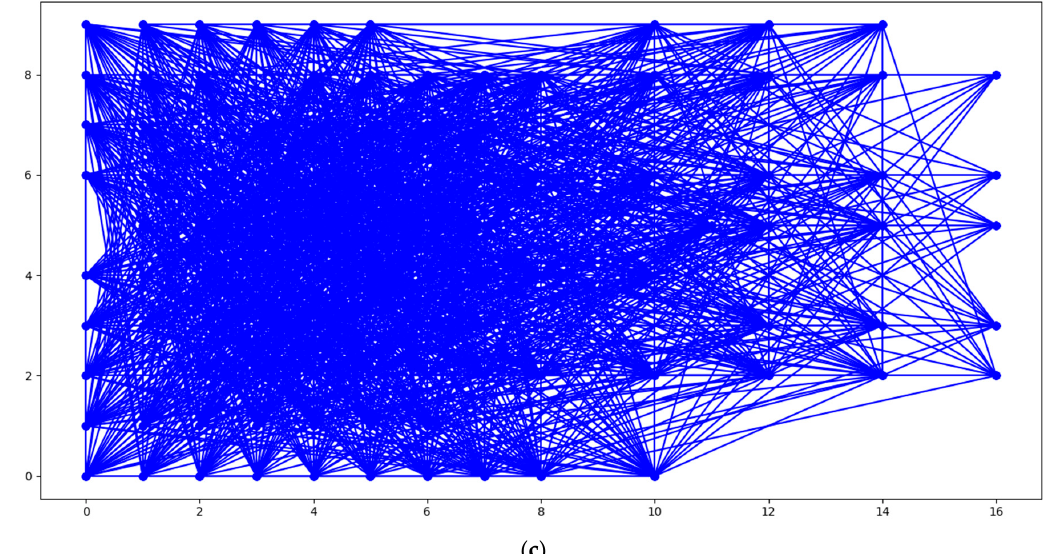
Figure 6. Represents the density graph where the sensor nodes are the vertices and the edges connect those whose distance belong in dangerous distance area ( a ) sparse graph with ann = 1.4, ( b ) medium dense with ann = 9.2 ( c ) very dense with ann = 22.6.